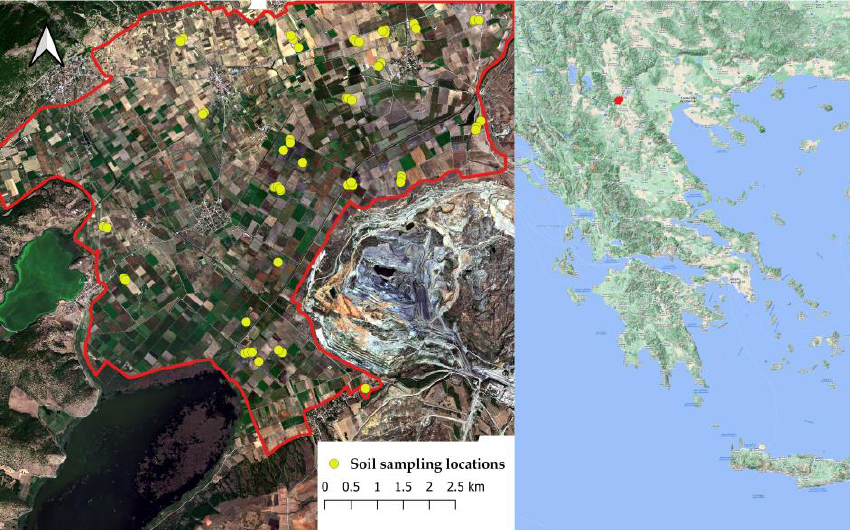
Figure 1. ( right ) Location of the study area and ( left ) true color HySpex imagery of the study area with the locations of the sampling points used for model calibration and validation.